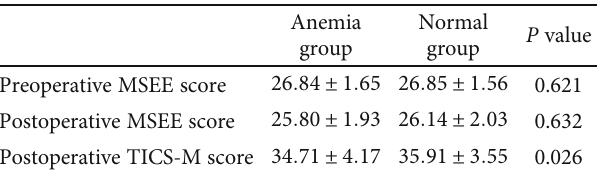
BMI=body mass index. Table 2: The MMSE score and TICS-M score between the two (cid:1) X group patients ( ± S